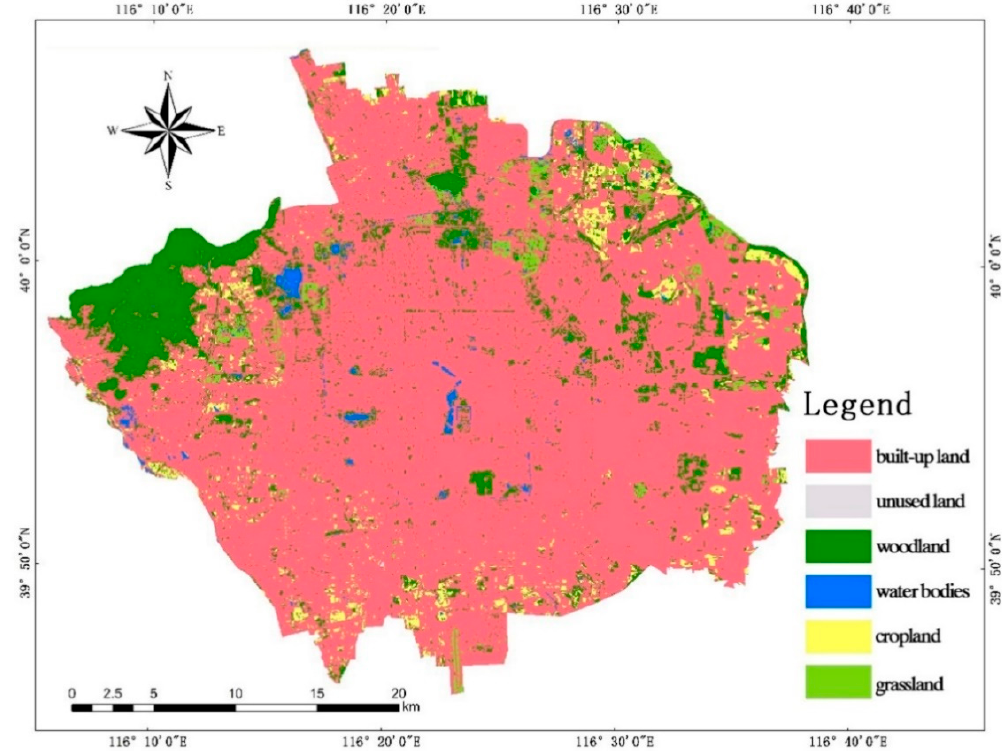
Figure 6. Results of the CA Model Simulation of Green Spaces in Beijing’s Central District in 2035 (Scenario 1).